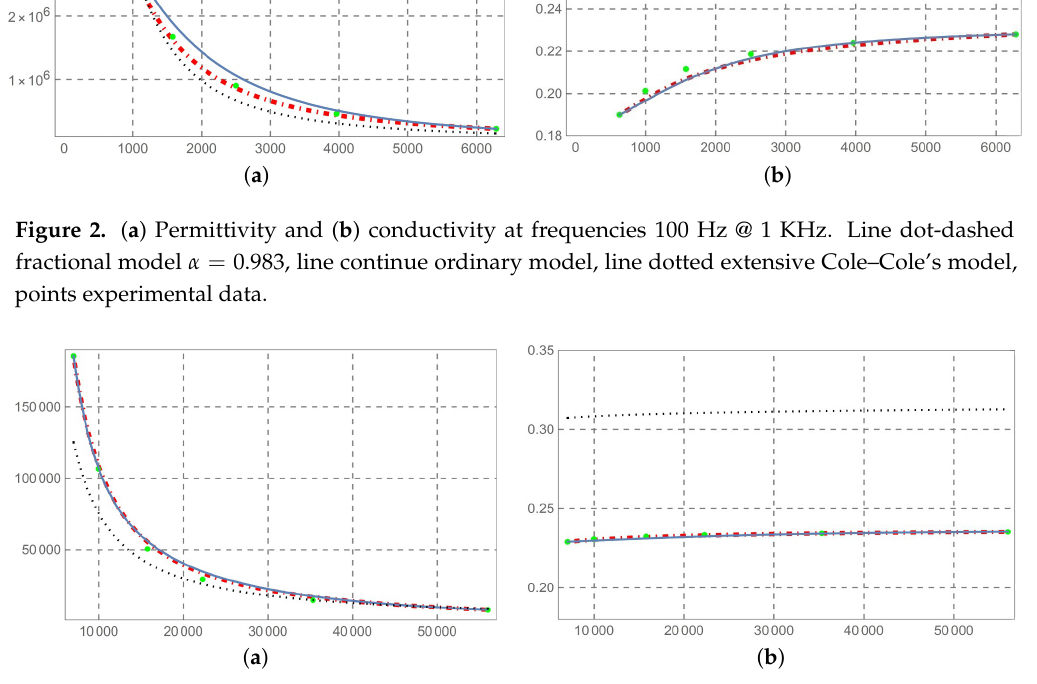
Figure 3. ( a ) Permittivity and ( b ) conductivity at frequencies 1 KHz @ 9 KHz. Line dot-dashed fractional model α = 0.985, line continue ordinary model, line dotted extensive Cole–Cole’s model, points experimental